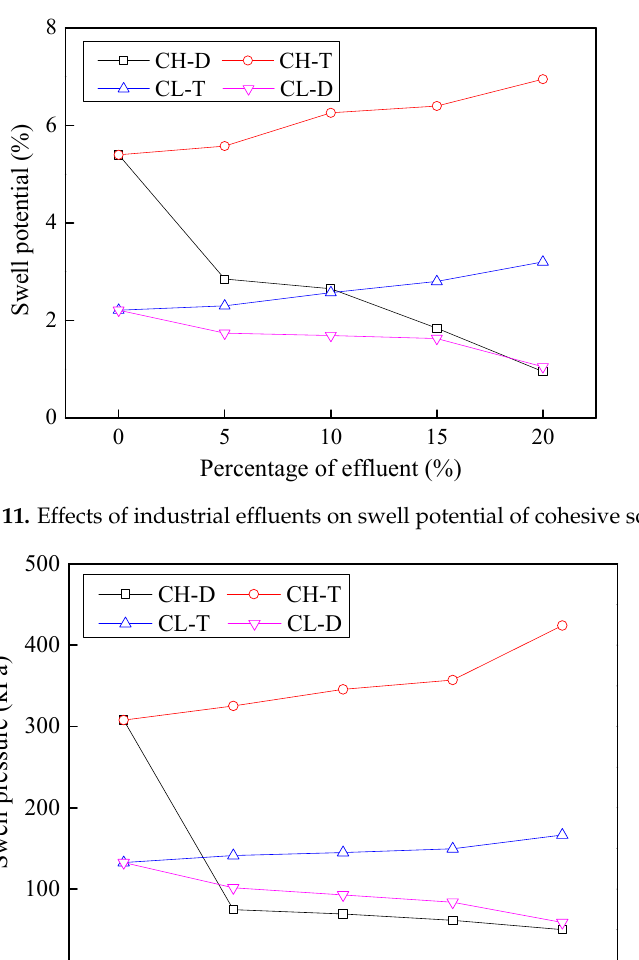
Figure 11. The swell potential of CL and CH soil samples increased by 44.8% and 28.7% with the